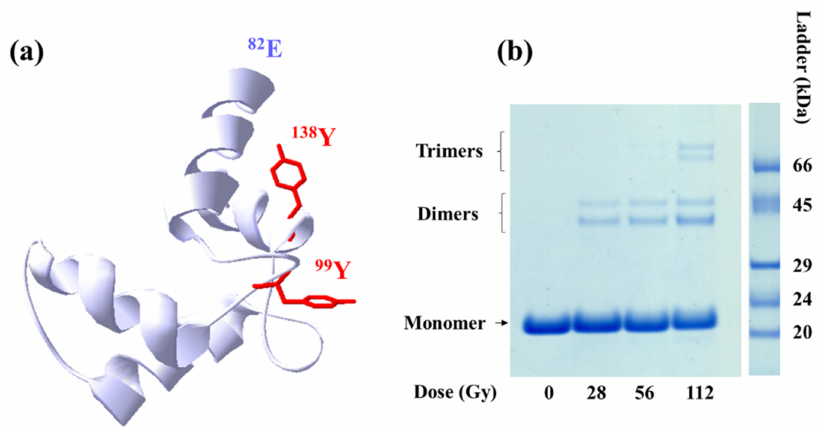
Figure 6. CaM oligomerization at 40 Gy in the presence of N 3 • . ( a ) Local representation of Tyr residues of CaM (from [25], 3cln PDB structure) and ( b ) SDS-PAGE of CaM after radiolytic oxidation by N 3 • for doses up to 112